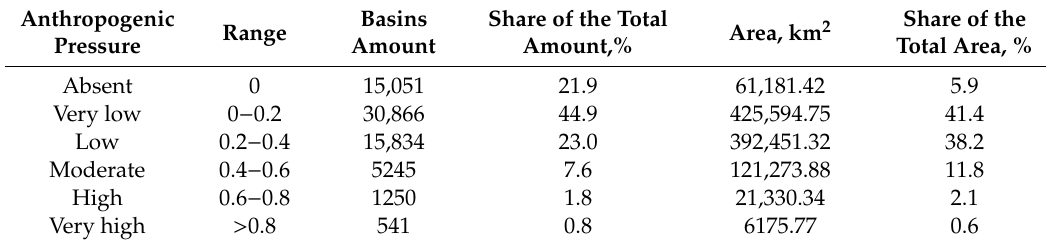
Table 8. The ratio of basins according to the degree of anthropogenic